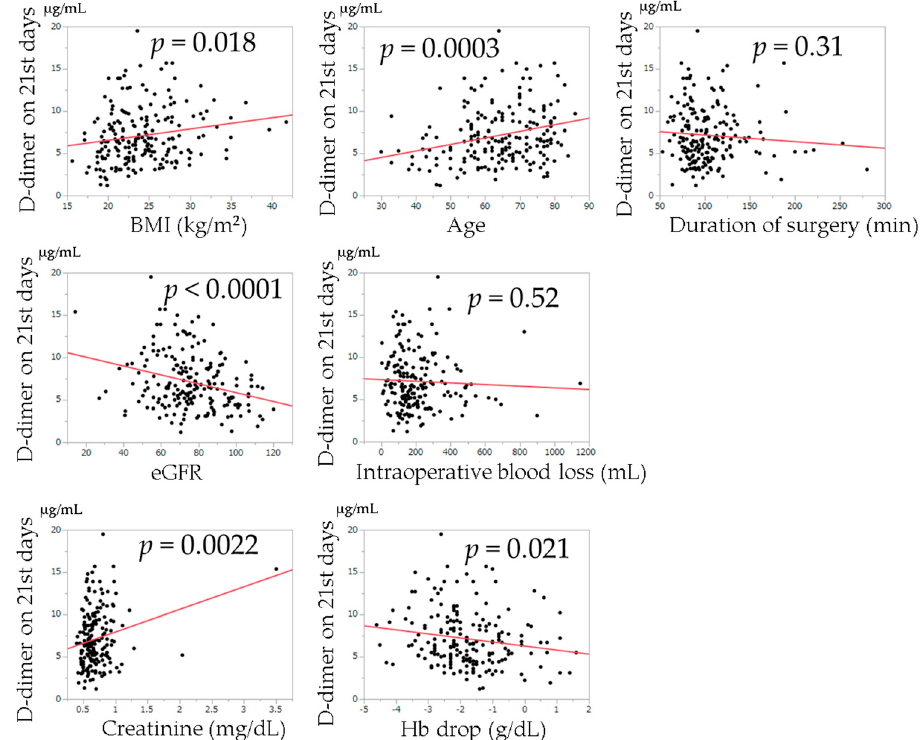
Figure 3. Univariate regression analysis of the relationships between each variable and D-dimer levels on the 14th postoperative day. The solid lines indicate regression lines.